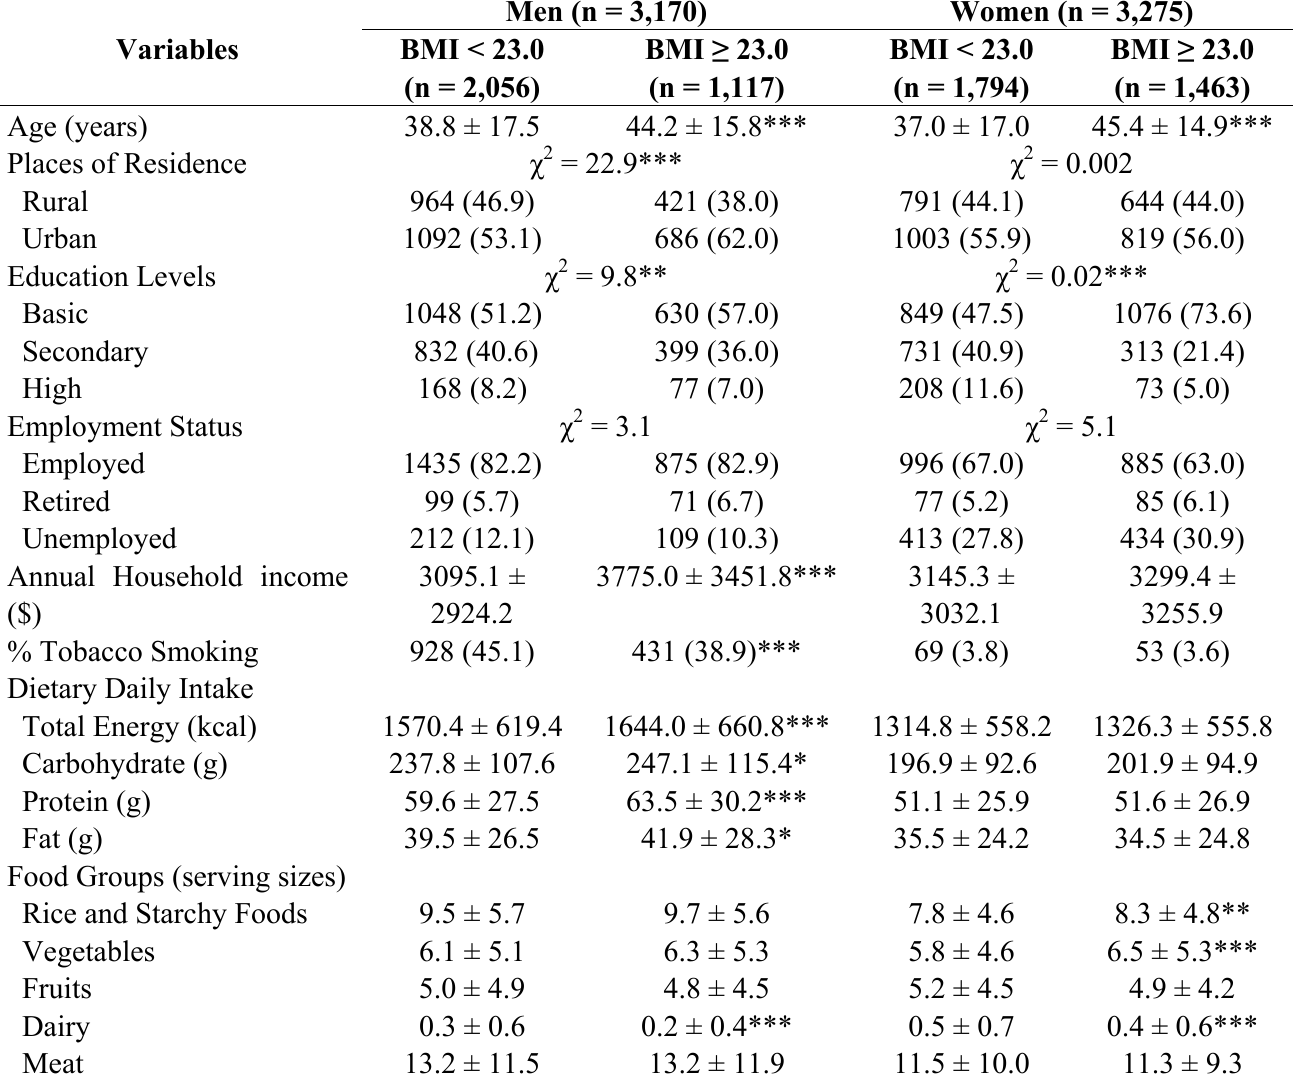
Table 2. Characteristics of a representative sample of Thai adults by gender and BMI